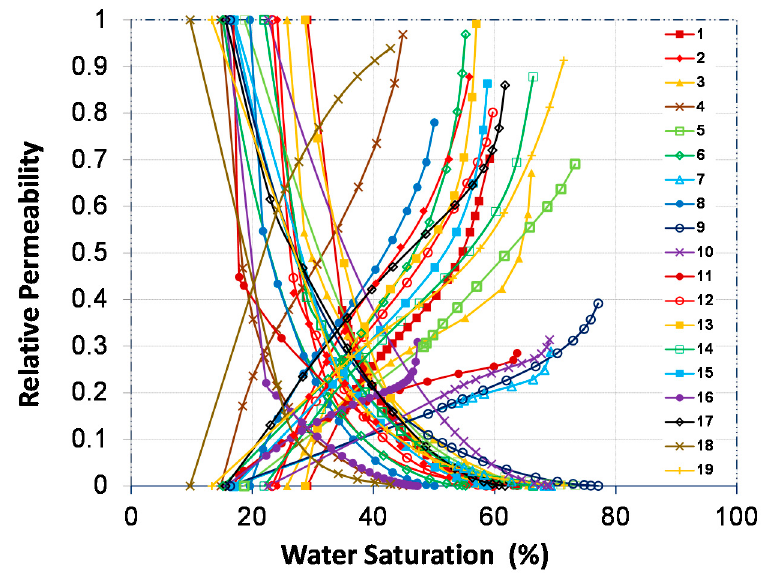
Figure 3. The oil and water relative permeability curves measured on 19 carbonate rock samples studied here.